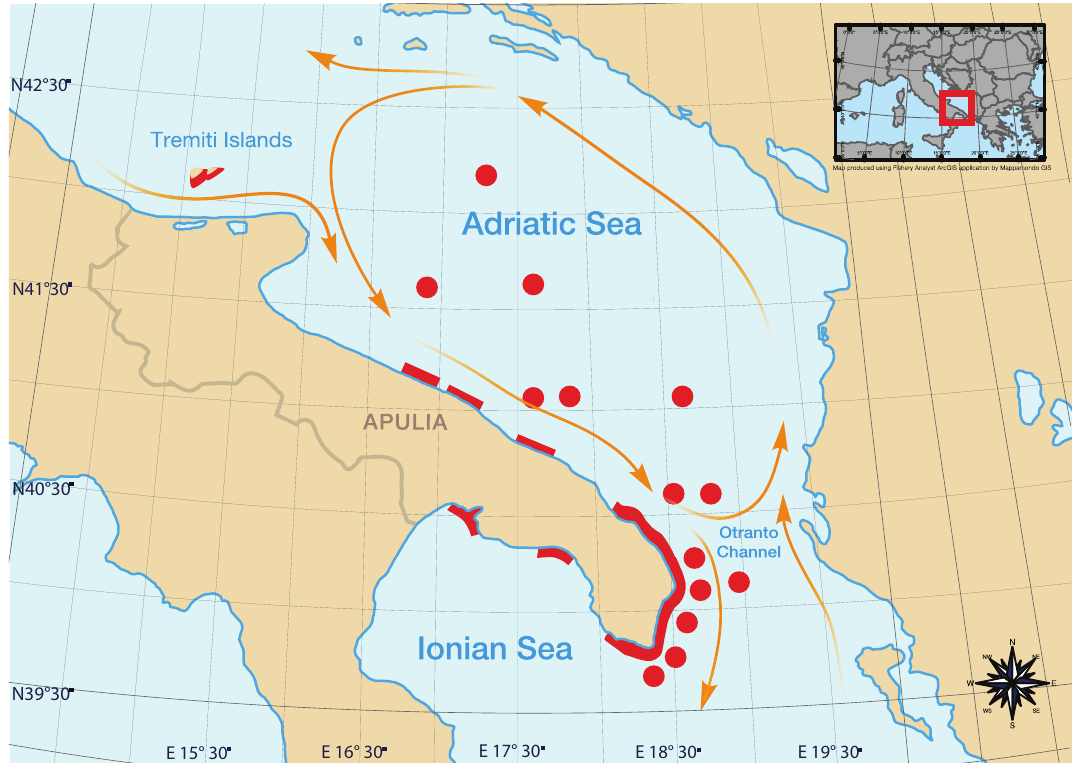
Figure 1. The peak of salp presence (early May 2013) along the Apulian coast. Coastal presences from both citizen science records and authors’ own observations were aggregated with the software Fishery Analyst, offshore records derive from onship observations during the CoCoNet Cruise. Yellow lines: trajectories of the main